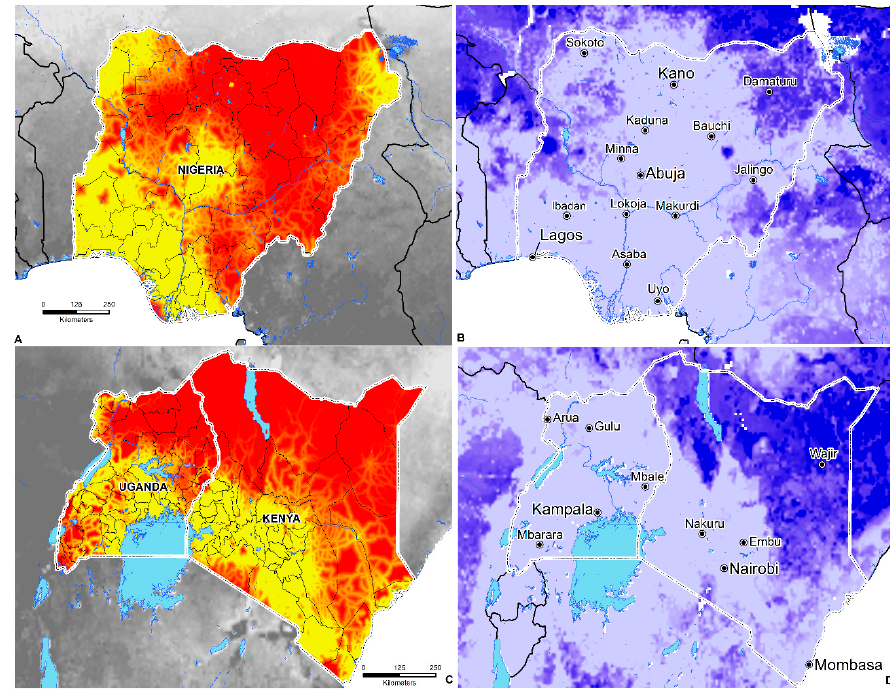
Figure 6. (A, C ) The proportion of people living on $1.25 a day in Nigeria, Uganda, and Kenya. Red corresponds to a higher proportion of the population living on $1.25 a day; yellow represents a lower proportion of the population living on $1.25 a day. ( B, D ) The coefficient of variation (CV) or measure of model uncertainty. Lighter colors = less uncertainty; darker colors = increased uncertainty.